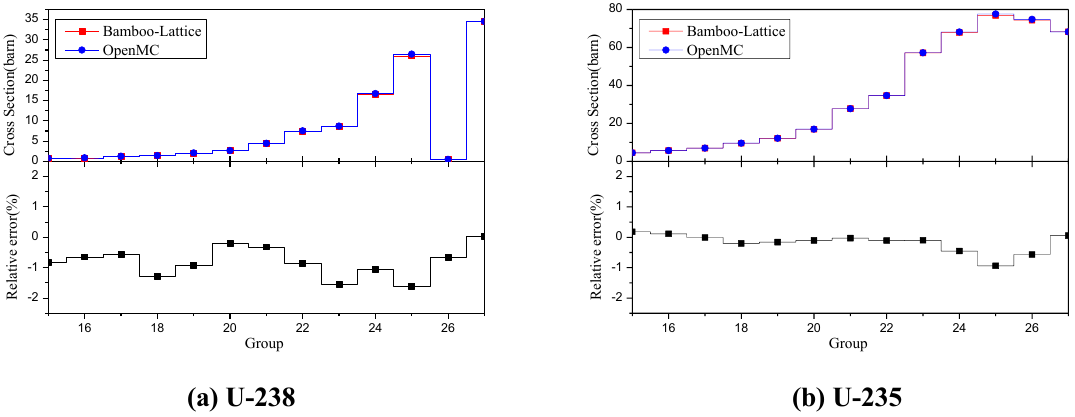
Figure 3. Comparison of the resonance absorption cross-sections for Followed